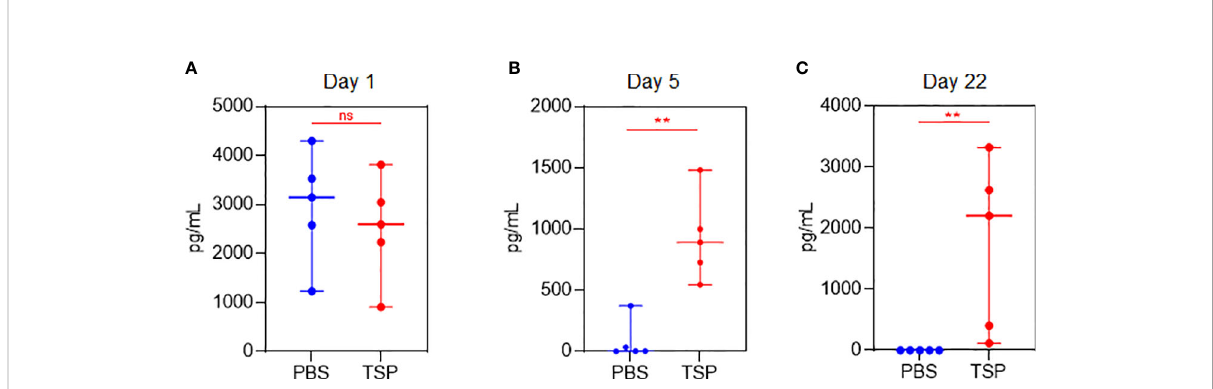
FIGURE 7 TSP drug combination over time differentially regulated Co-mV-induced production of SARS-CoV-2 spike antigen levels in Balb/C mice. Sandwich ELISA (as described in materials and methods) to assess the SARS-CoV-2 spike protein antigen in the non-hemolyzed sera of vaccine alone and TSP-pretreated vaccine group using 5 samples from each group on (A) day 1, (B) day 5, and (C) day 22. In panels (A-C) , the data was represented as median values ± 95% CI; blue indicates PBS group and red indicates TSP group. Statistical comparisons were performed using Mann-Whitney test (** p = 0.004; ns, not signi fi cant). Co-mV, COVID-19 mRNA vaccine; PBS, phosphate buffered saline; T, tacrolimus; S, sirolimus; P, prednisone; CI, con fi dence